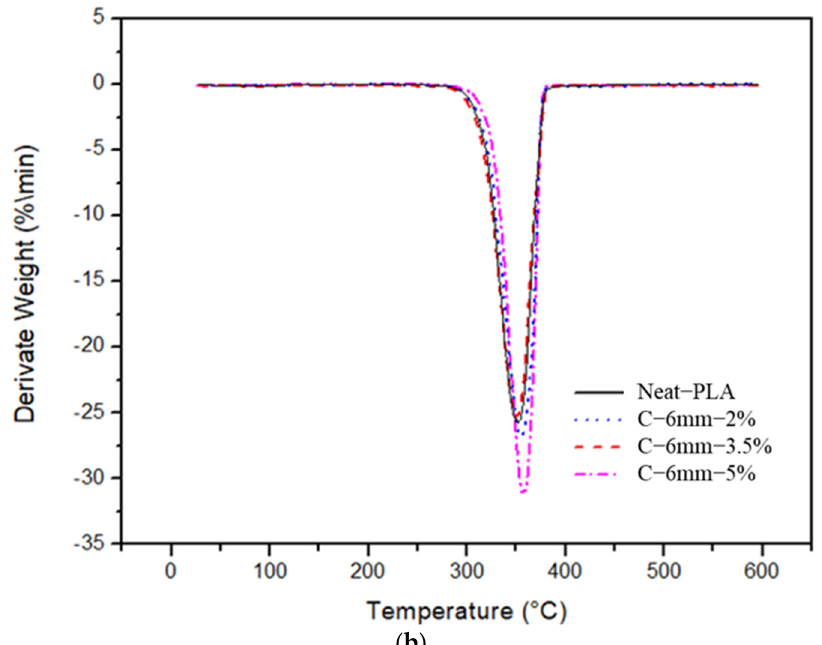
Figure 13. TGA analysis data: ( a ) TG curves; ( b ) DTG curves. Table 5. TGA analysis